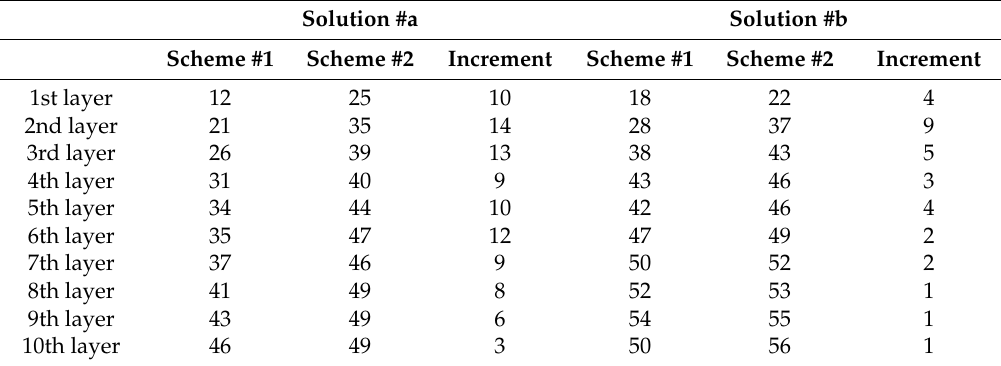
Figure 5. ( a ) Grayscale graph of the number of signal rays passing through each voxel in Solution #a; ( b ) Grayscale graph of the number of signal rays passing through each voxel in Solution #b. Table 3. Number and increment of voxels crossed by signal rays in different layers of Solutions #a and #b by two schemes.